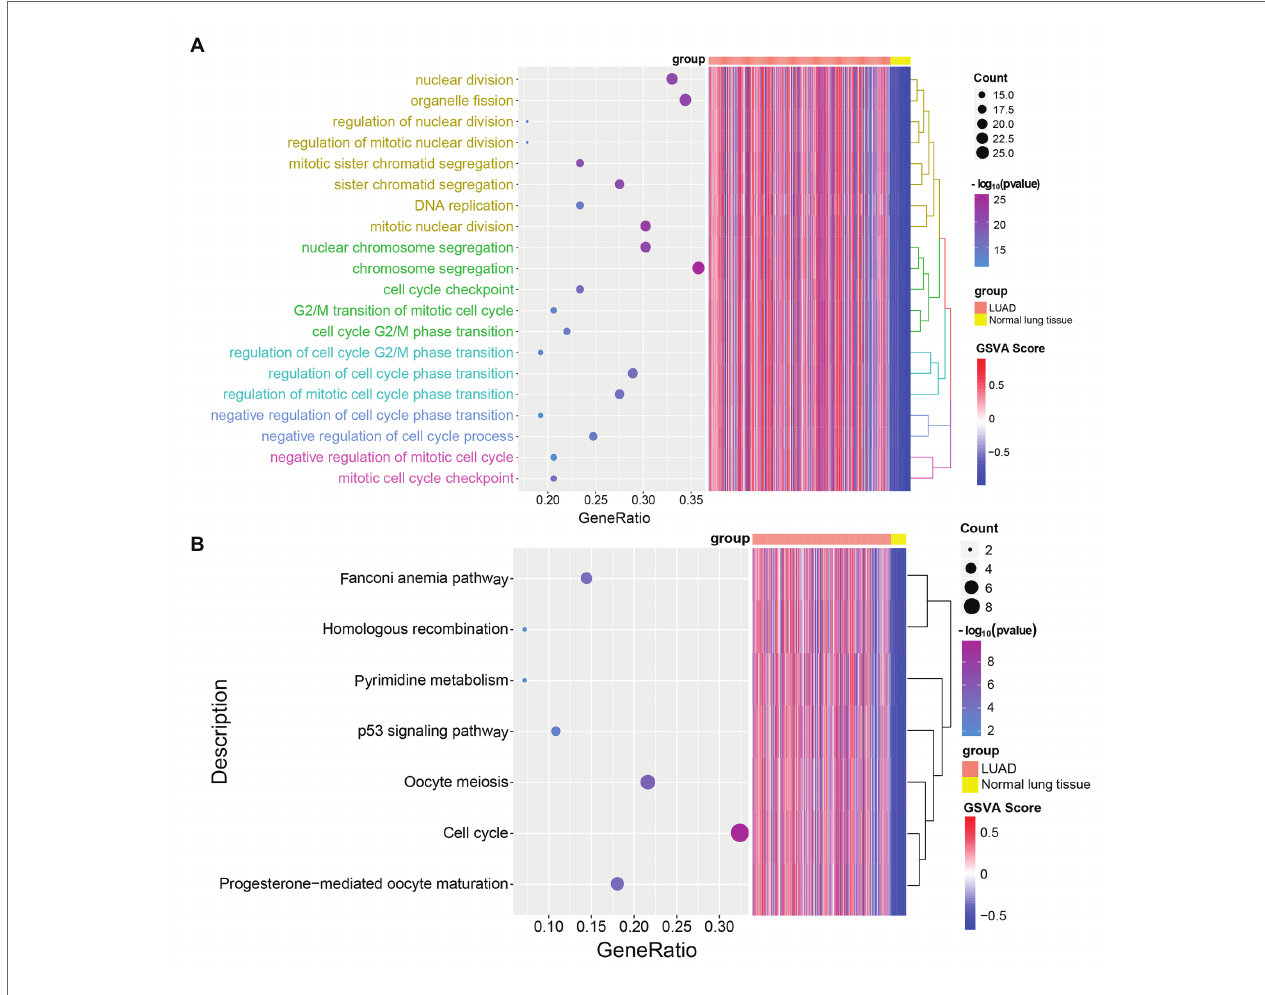
FIGURE 6 | Gene Ontology (GO) biological process (BP) and Kyoto Encyclopedia of Genes and Genomes (KEGG) pathways enrichment analysis of LUAD-unfavorable genes. (A) Biological process of LUAD-unfavorable genes. (B) KEGG pathway analysis of LUAD-unfavorable